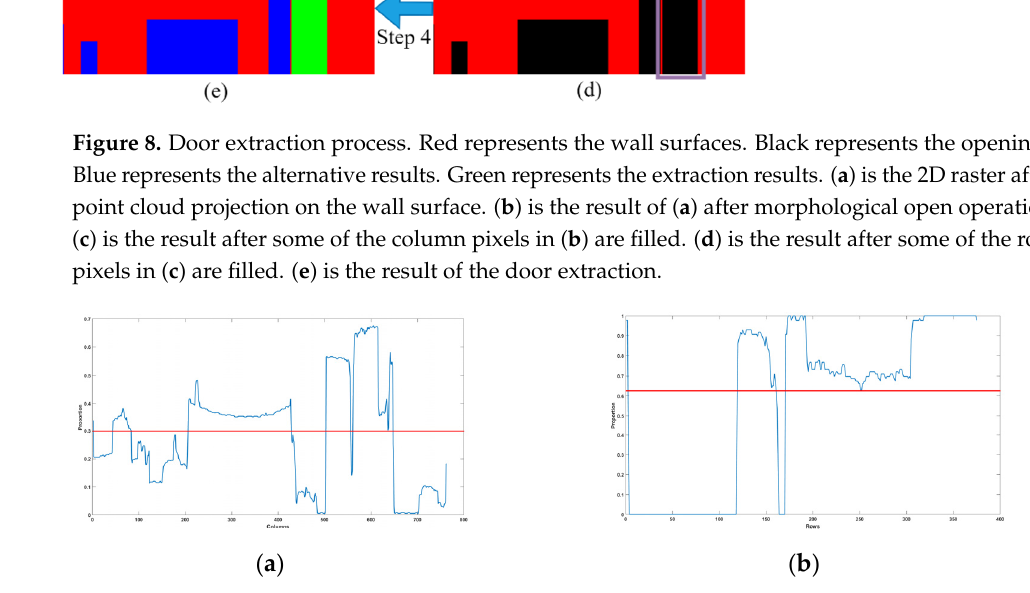
Figure 9. Statistics graph of wall projection raster. ( a ) represents the column statistics graph in step 2 of Figure 8b represents the row statistics graph of the purple boxed area in Figure 8b. The red line indicates the threshold values. ( b ) represents the column statistics graph in step 3 of Figure